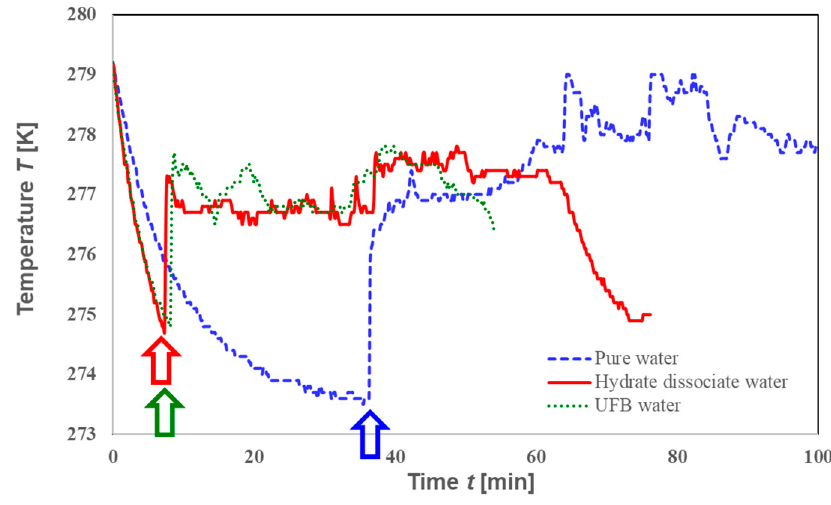
Figure 3. Temperature profile during hydrate formation (arrows indicate the formation points).